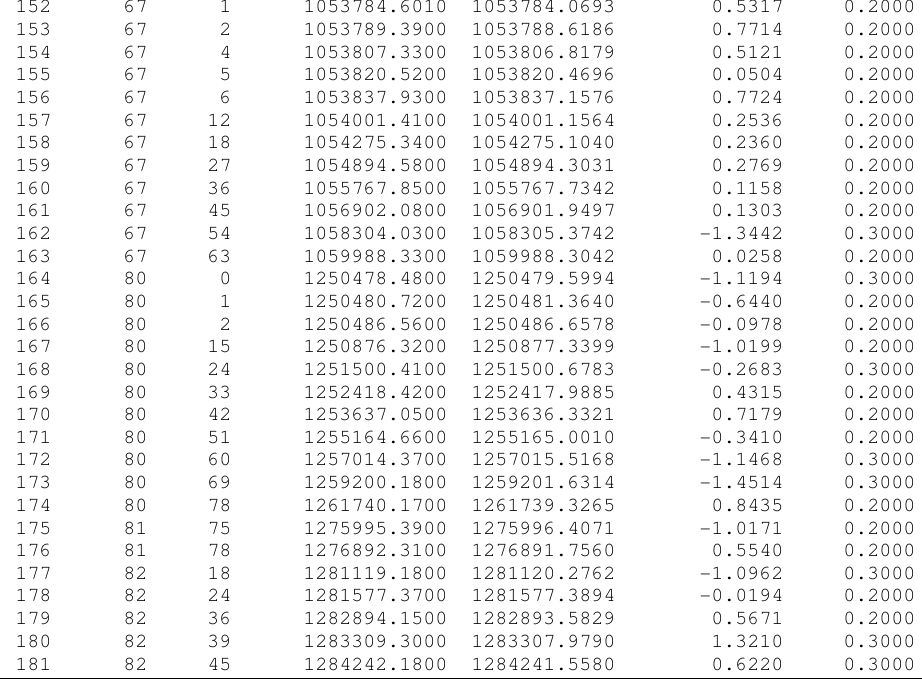
Table 2 . Correlation Coefficients for PF